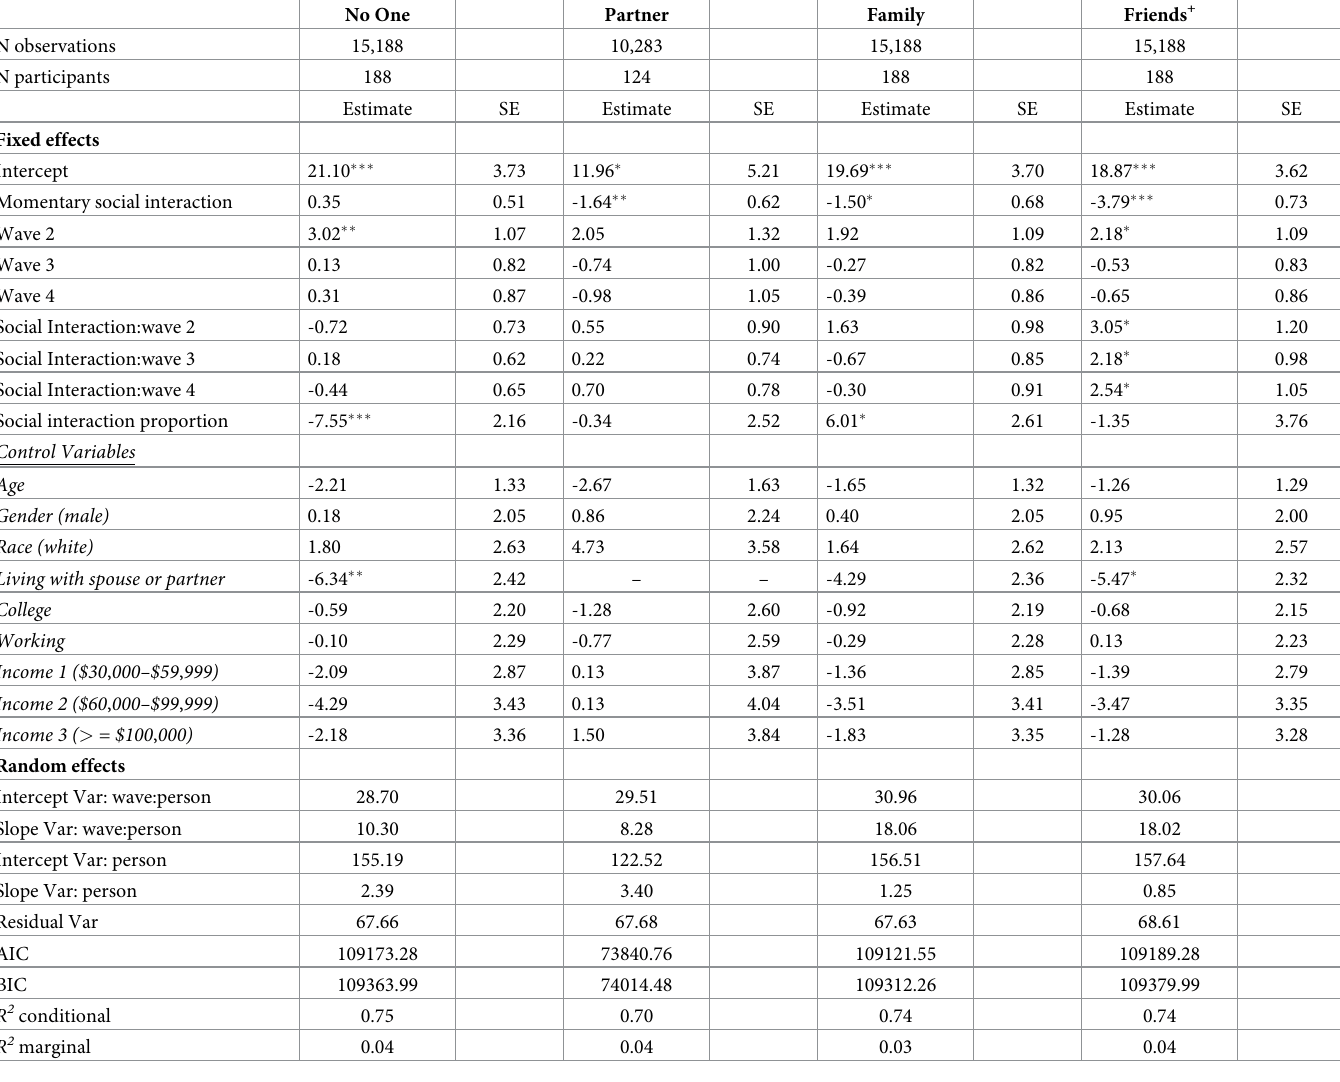
Table 7. Multilevel models with various social interactions, wave, and social interactions by wave predicting